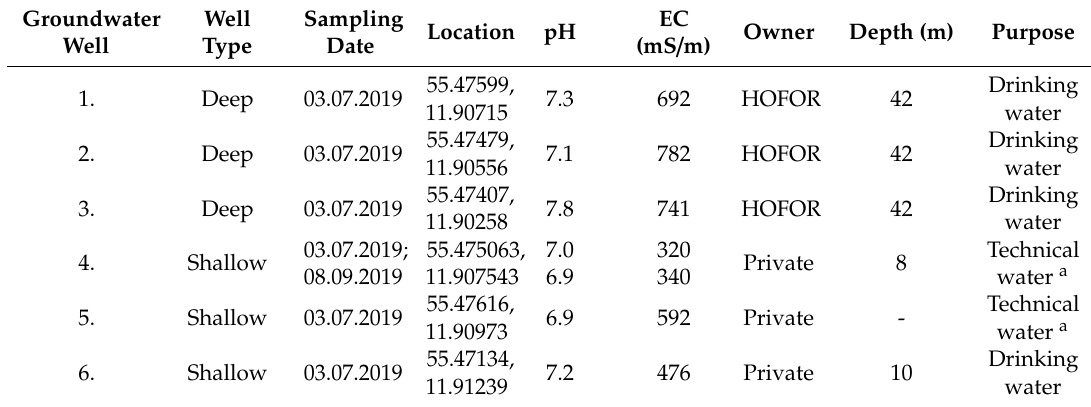
Table 5. Description of the groundwater wells included in